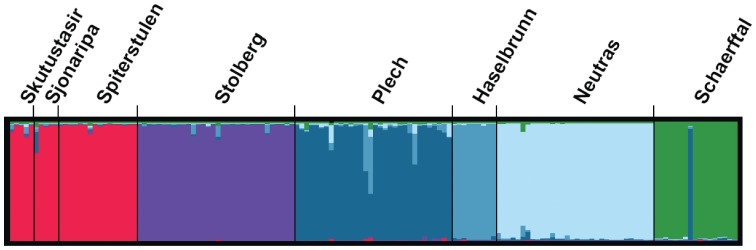
Population structure as inferred from the best fit number of groupings in STRUCTURE.Best fit model had K = 6 populations. Each color represents population assignment inferred from best fit STRUCTURE output. Individuals are shown as a separate line in the box of the population in which they were collected as labeled on top.